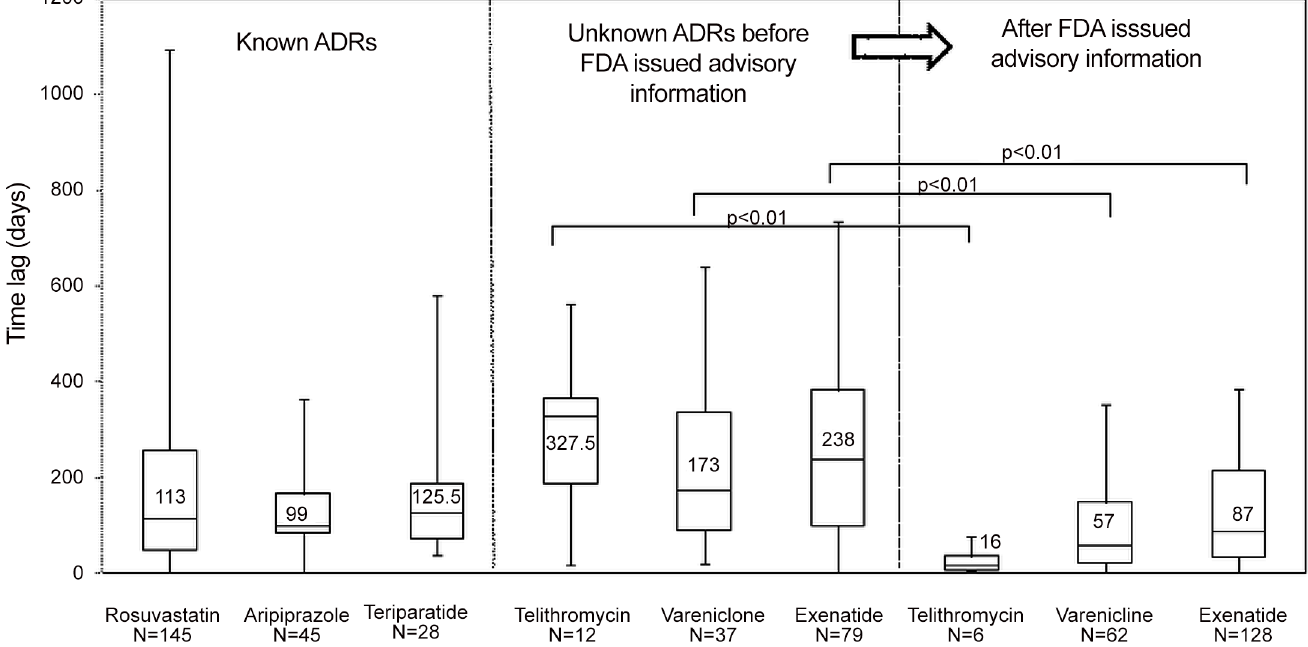
Fig 1. Time lag from the onset of known and unknown ADRs until report to the FDA for each study drug and effect of FDA advisory information on reporting